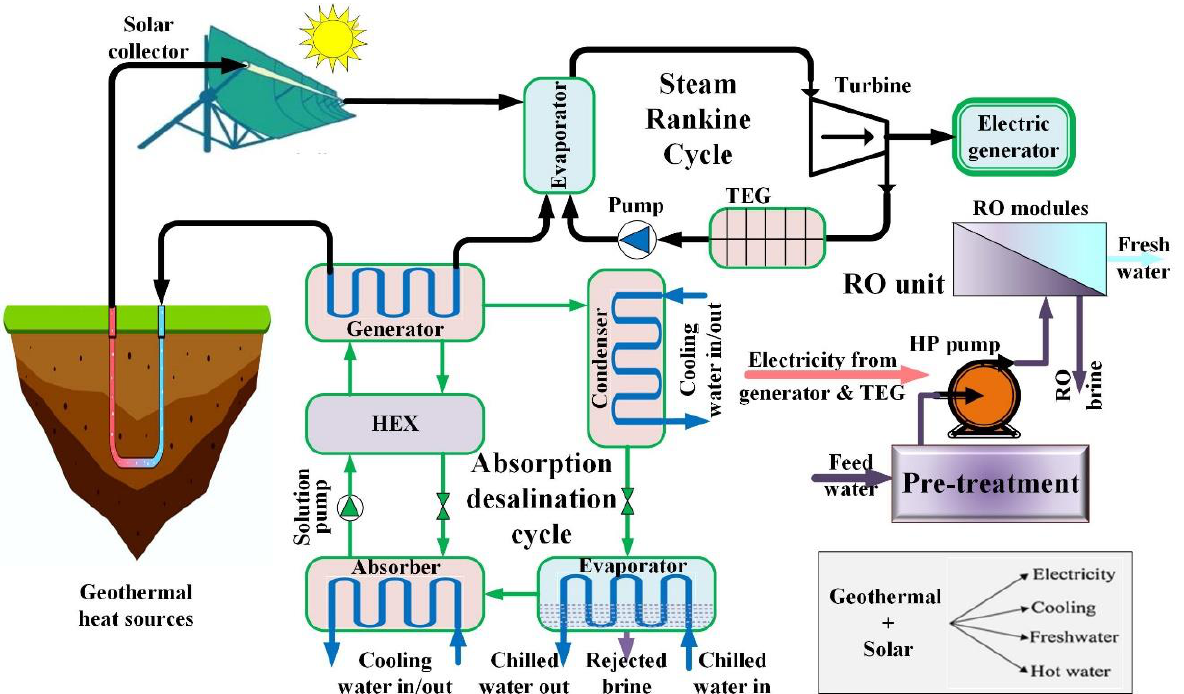
Figure 7. Schematic of multigeneration energy with a thermoelectric generator (TEG) for a hybrid RO-ABR system (adapted from [89]).